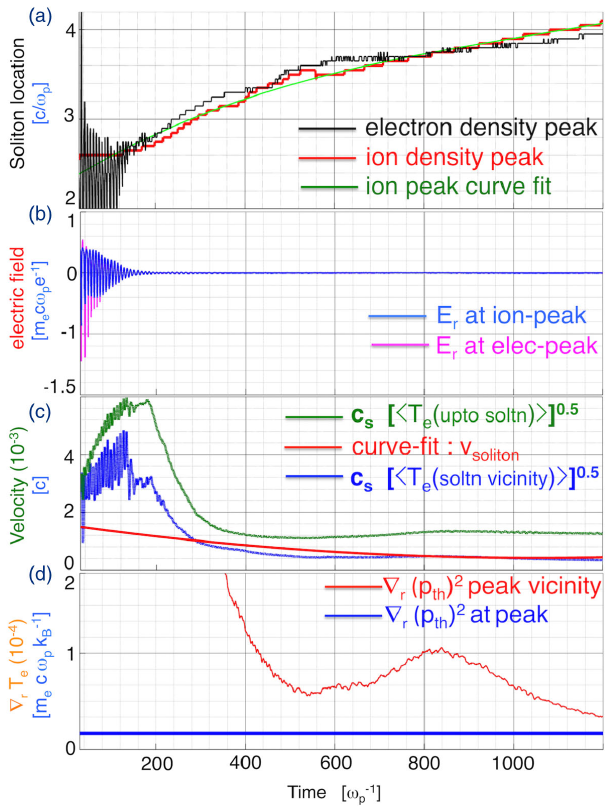
FIG. 6. Time evolution of the cylindrical ion soliton. (a) Elec- tron (black) and ion (red) spike radial positions (in terms of c ω − 1 with time and a third-order fit (green) for the position of the ion density-spike of the soliton. (b) Radial fields of the electron bubble oscillations (in terms of m density spike (magenta) and at the ion density spike (blue). (c) Radial velocity of the ion density spike of the soliton calculated from the third-order fit curve (red). An estimate of the sound speed (green) using the mean temperature, between the axis and the soliton location (green) and in the vicinity of the soliton peak (blue), in the expression c the plasma is not isothermal the mean temperature is calculated by averaging the temperature of electrons over the indicated spatial region. (d) Gradient of the electron temperature at the soliton ion density peak (blue) and in the vicinity of the peak (red). The vicinity of the ion density peak of the soliton is defined as shown in Fig. 5.